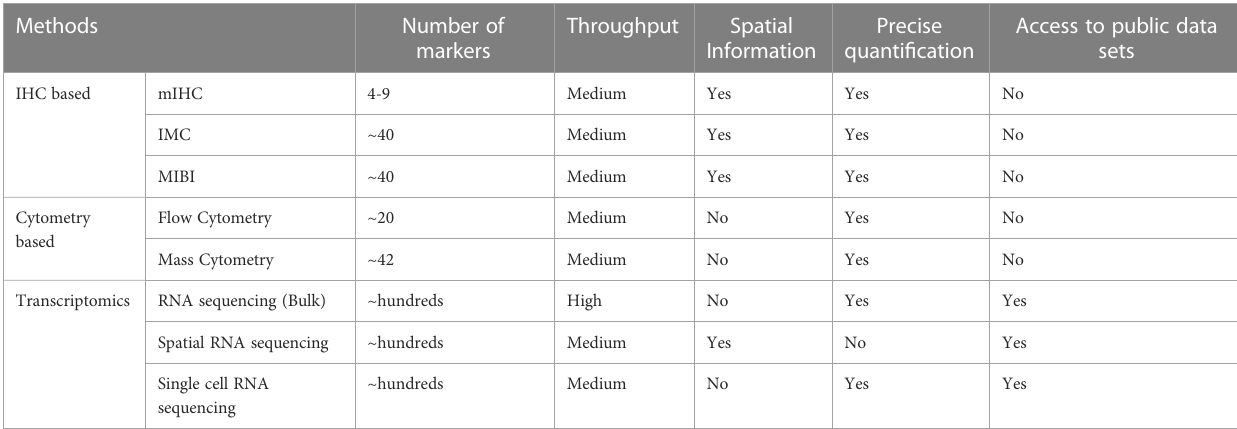
TABLE 1 Summary of techniques used to assess